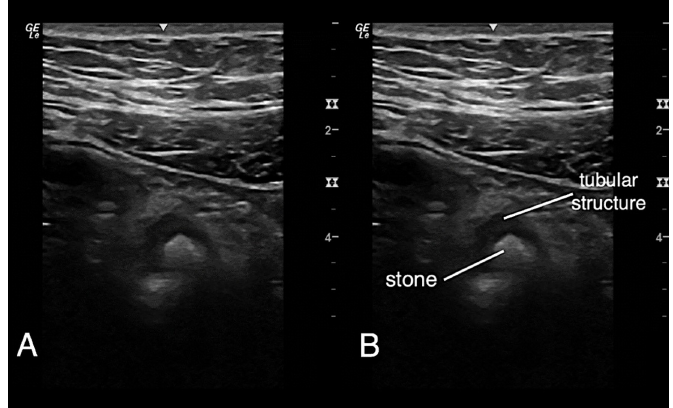
Image 3. Ultrasound right lower quadrant, short axis, high frequency linear probe. A hyperechoic circular object is noted within a hypoechoic tubular structure. The hyperechoic object is a ureteral stone noted within a dilated